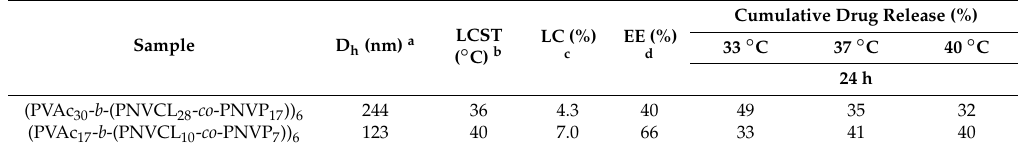
Table 5. Properties of MTX-loaded star polymer aggregates.